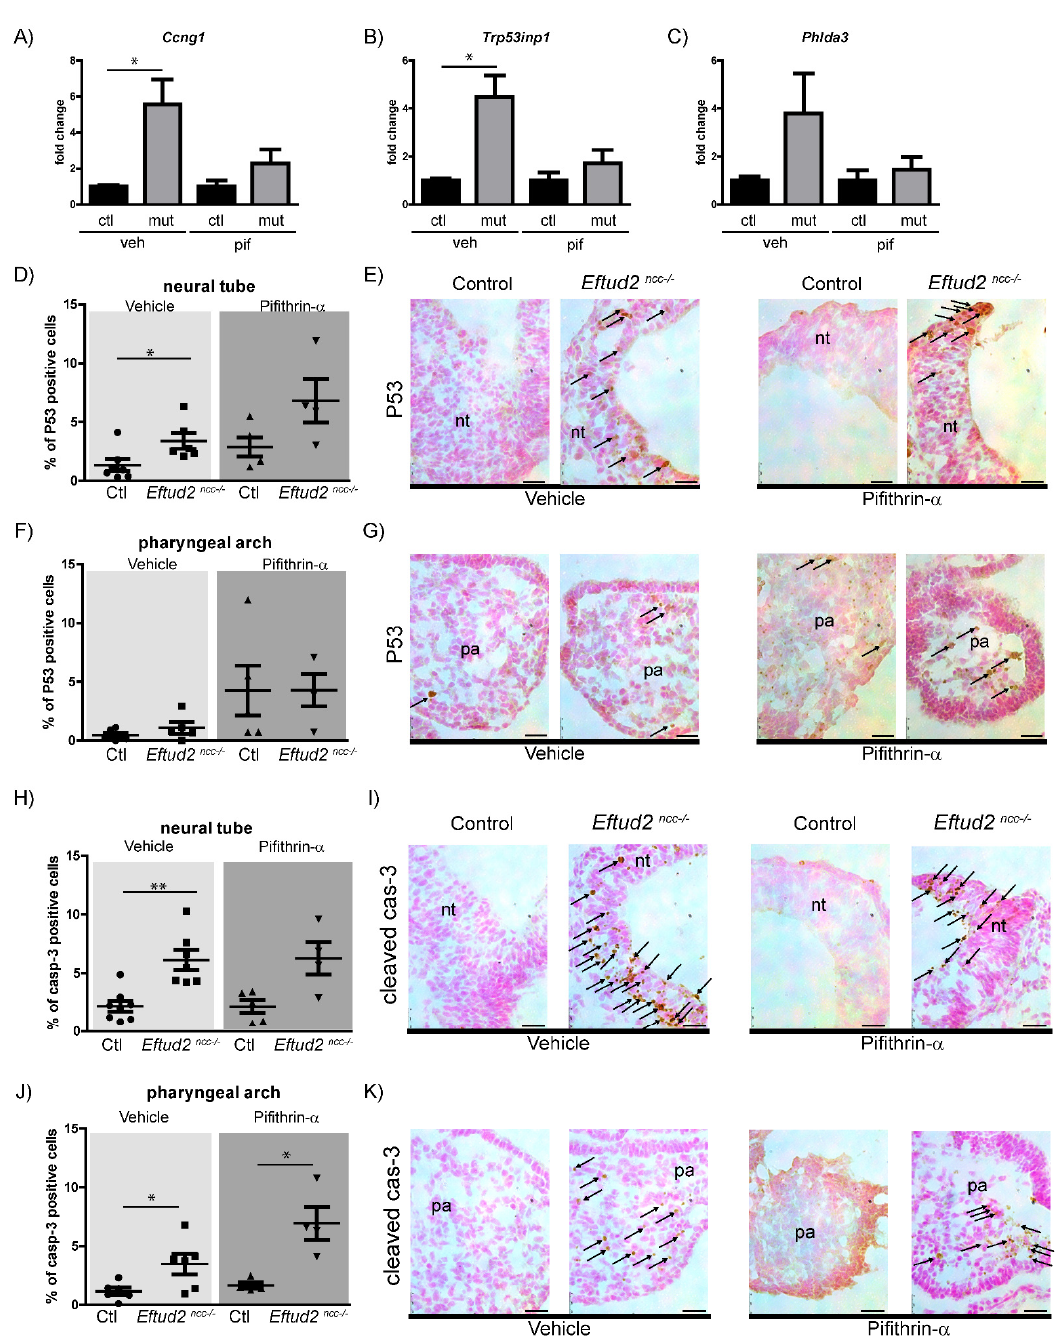
(Figure 1H,J). In addition, pifithrin- α treatment did not impact proliferation in the head of Eftud2 ncc − / − mutant embryos (Figure S1). These data indicate that pifithrin- α reduced apoptosis in the neural tube of Eftud2 ncc − / − embryos, but not in the pharyngeal arch. Alto- gether, our data suggest that the improved craniofacial development found in pifithrin- α treated Eftud2 ncc − / − embryos at E9.5 was due to reduced P53-activity and P53-associated apoptosis in the neural tube.